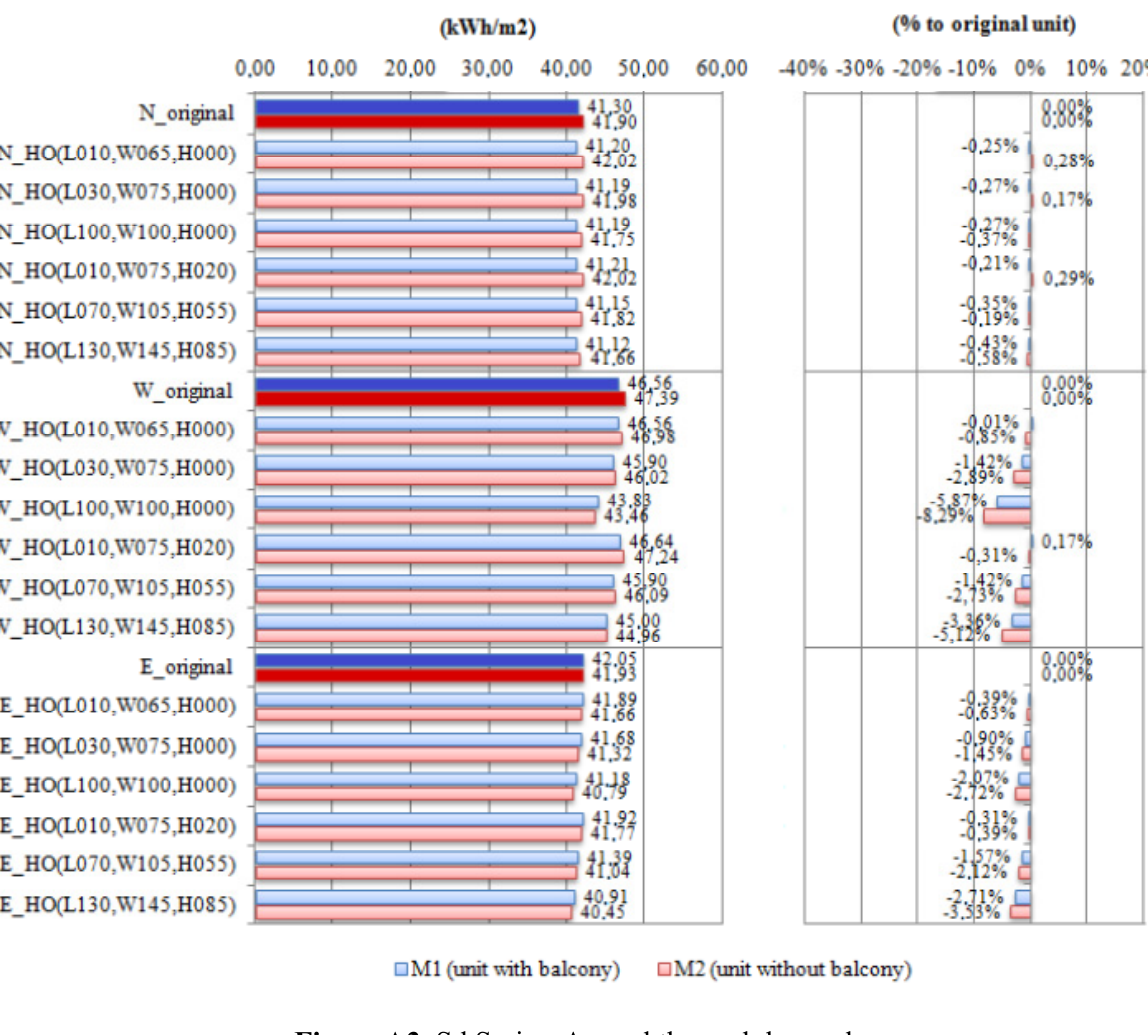
Figure A3. Sd Series: Annual thermal